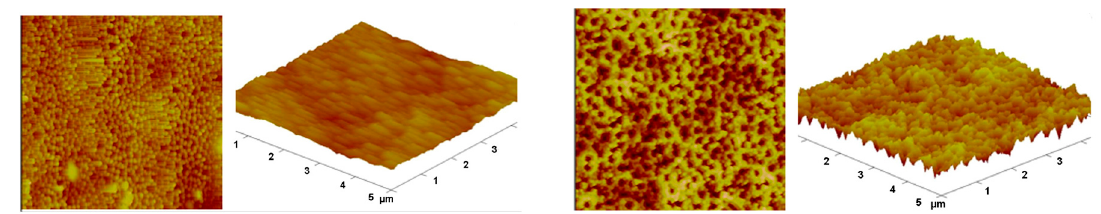
Figure 1. Surface morphology of ceramic membranes: ( left ) 200-nm anodisc with 0.030 mg of C60 per cm − 2 and ( right ) 200-nm thick anodisc with 0.058 mg of C60 per cm − 2 [23].